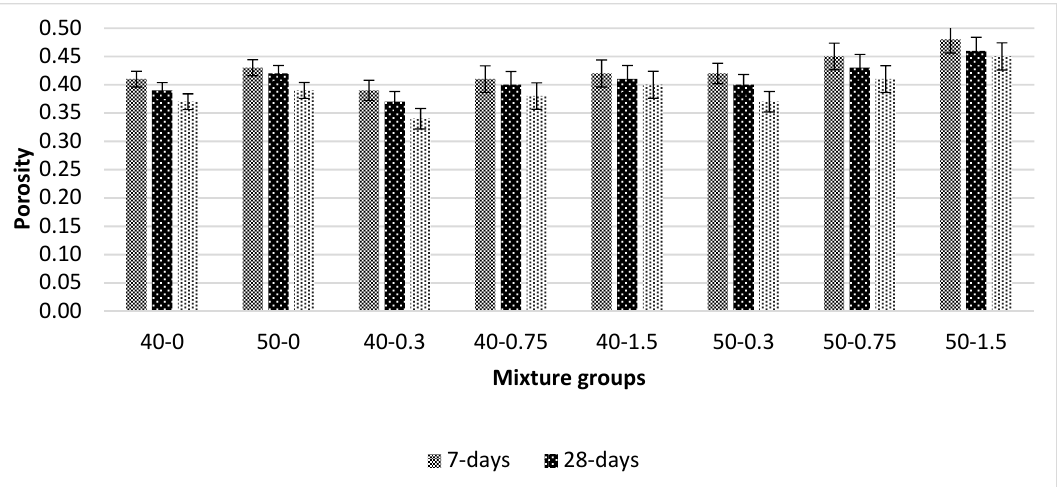
Figure 5. Porosity values for basalt-reinforced bottom ash cement paste composites at 7, 28 and 56 days of curing.